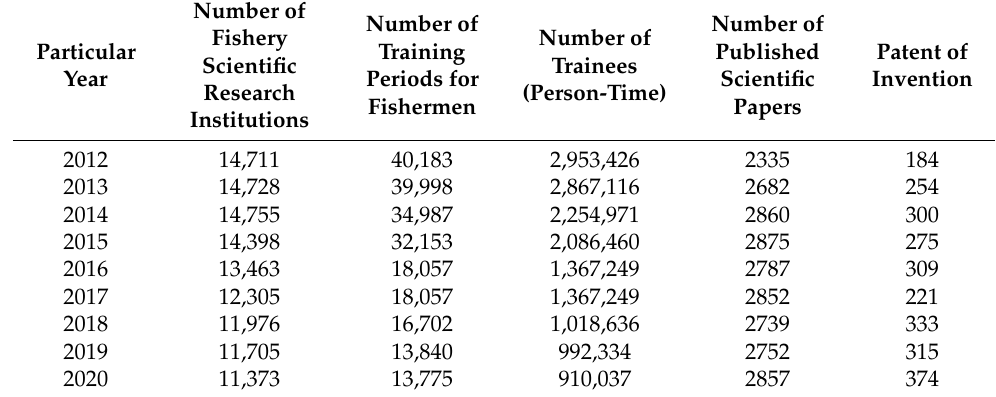
Table 5. Promotion of fishery science and technology in China from 2012 to 2020.